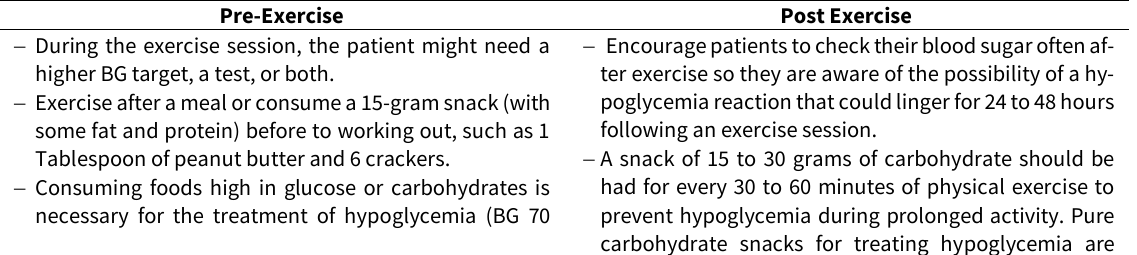
Table 2. Management of Hypoglicemia